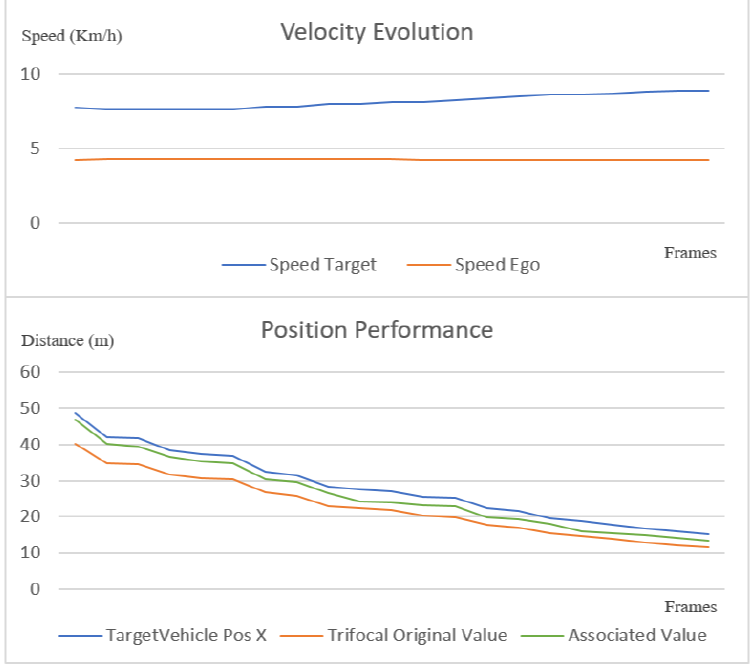
Figure 21. Another scenario that demonstrates the performance of the object association.